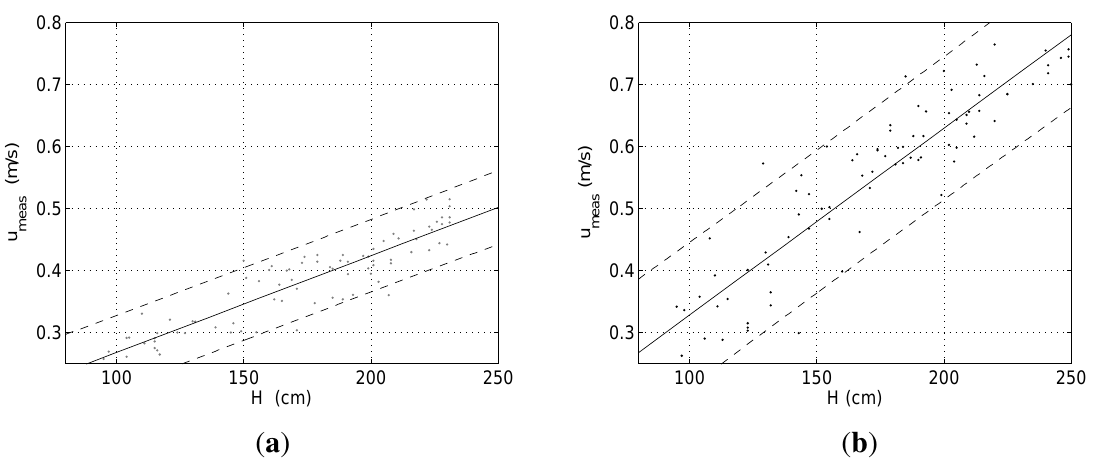
Figure 11. Velocity peaks versus tidal heights: ( a ) Incoming tide and ( b ) outgoing tide. Dashed lines show the 95% confidence interval.